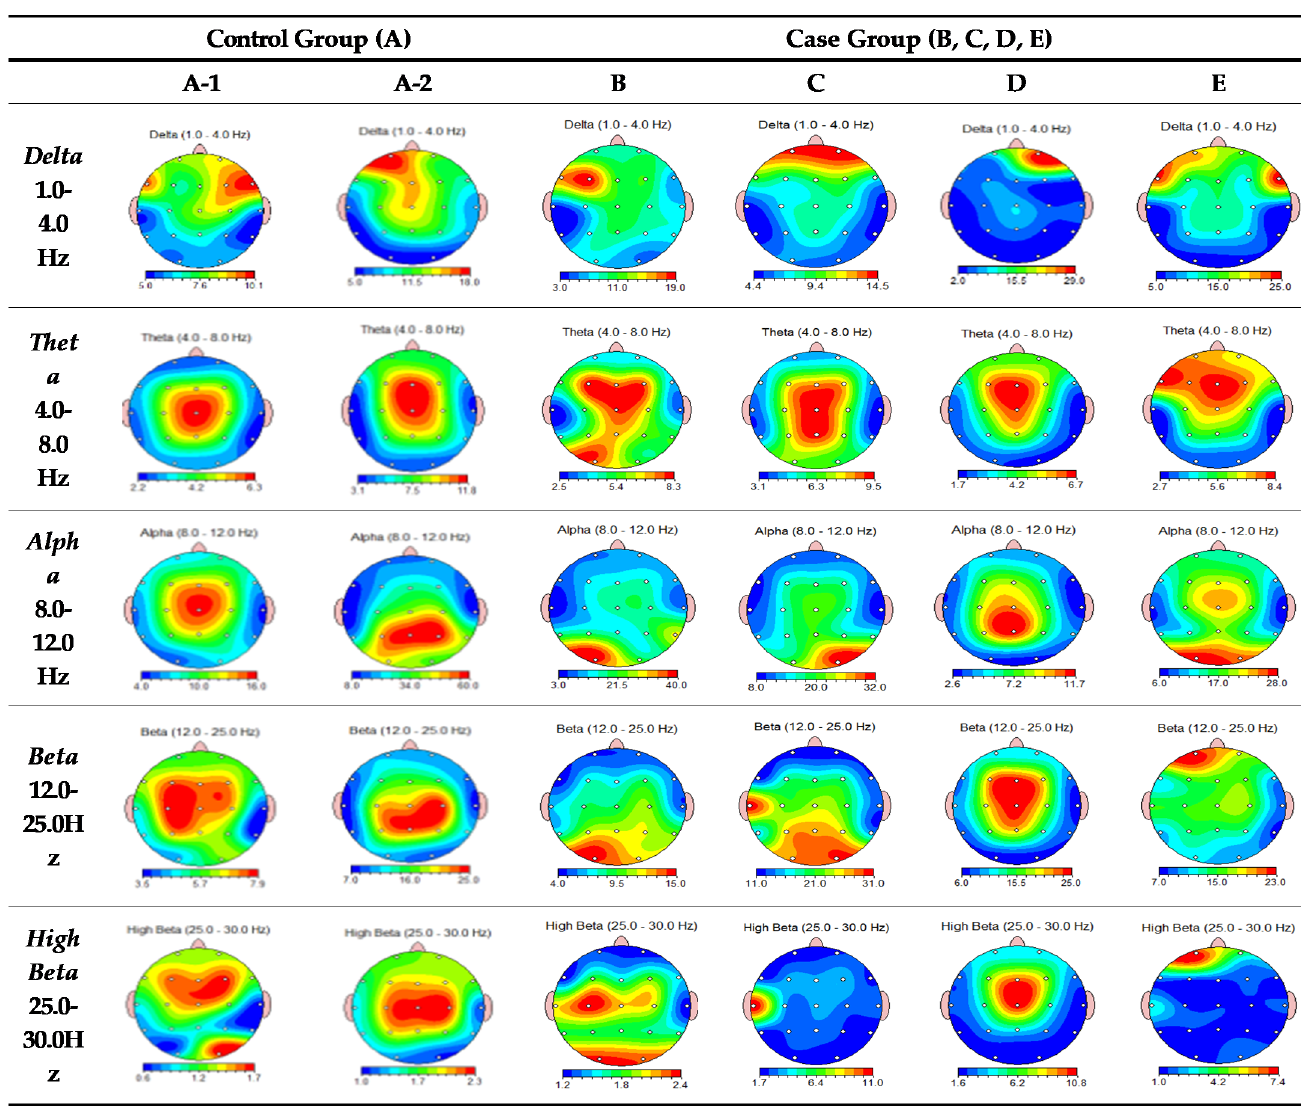
Figure 2. EC FFT absolute power brain mapping.